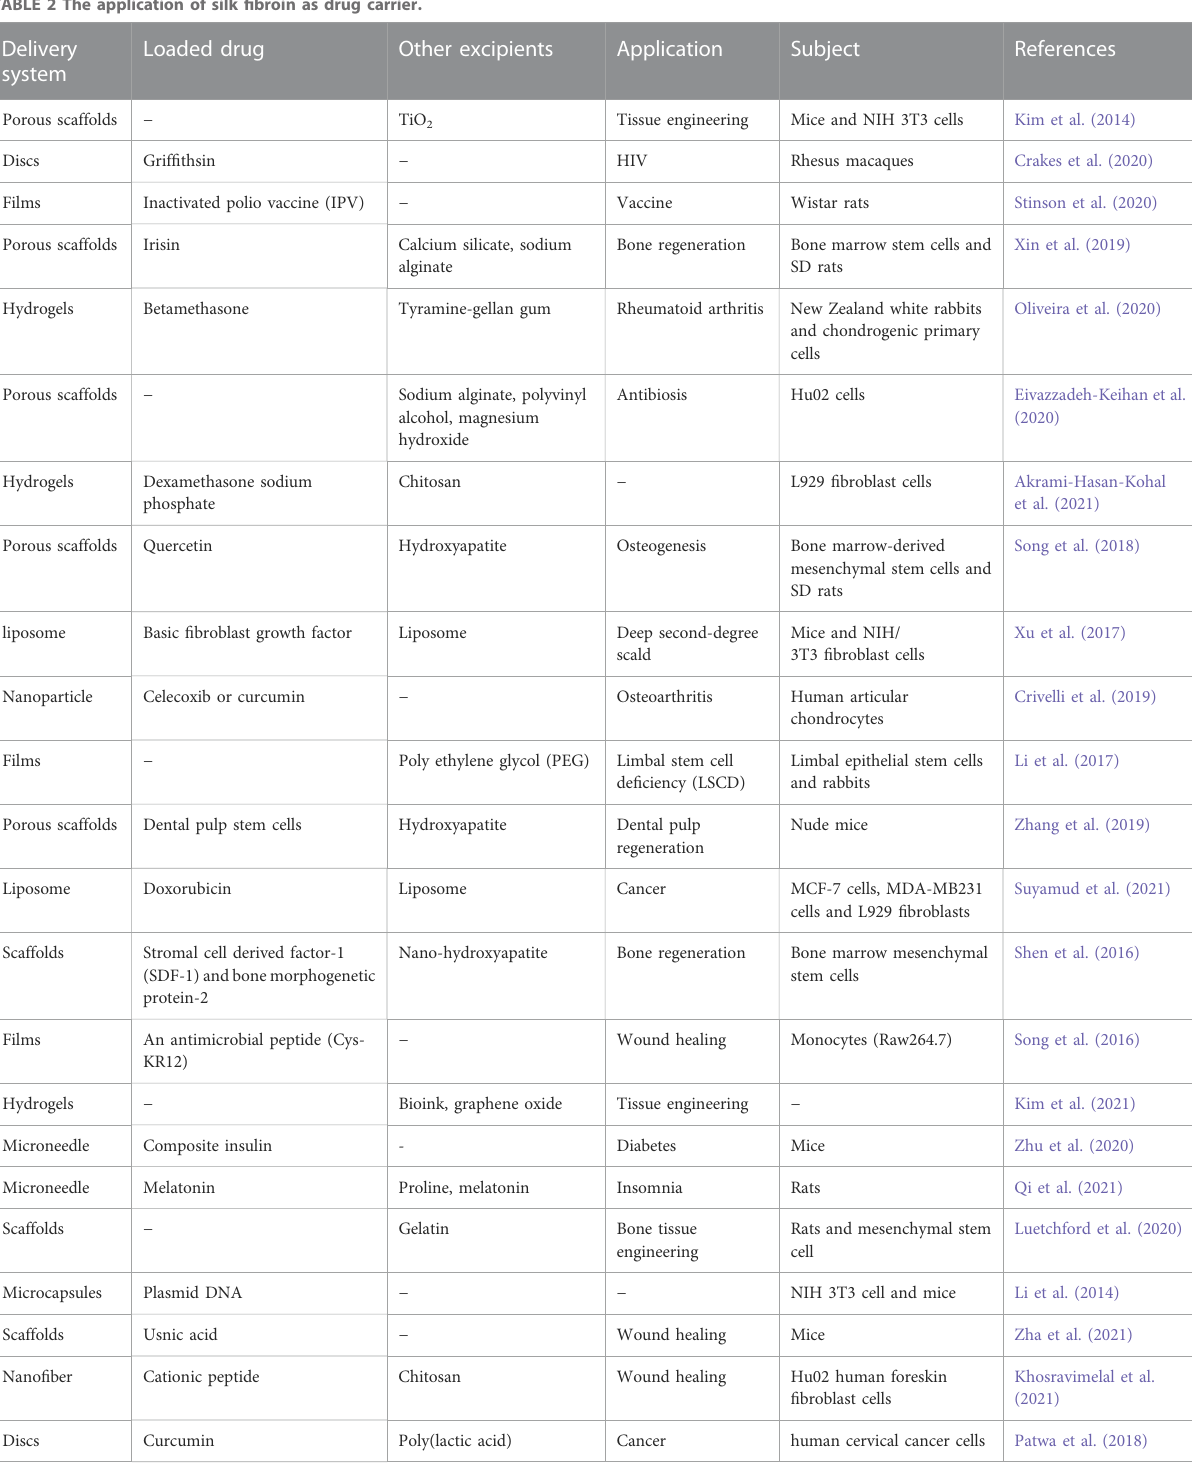
TABLE 2 The application of silk fi broin as drug